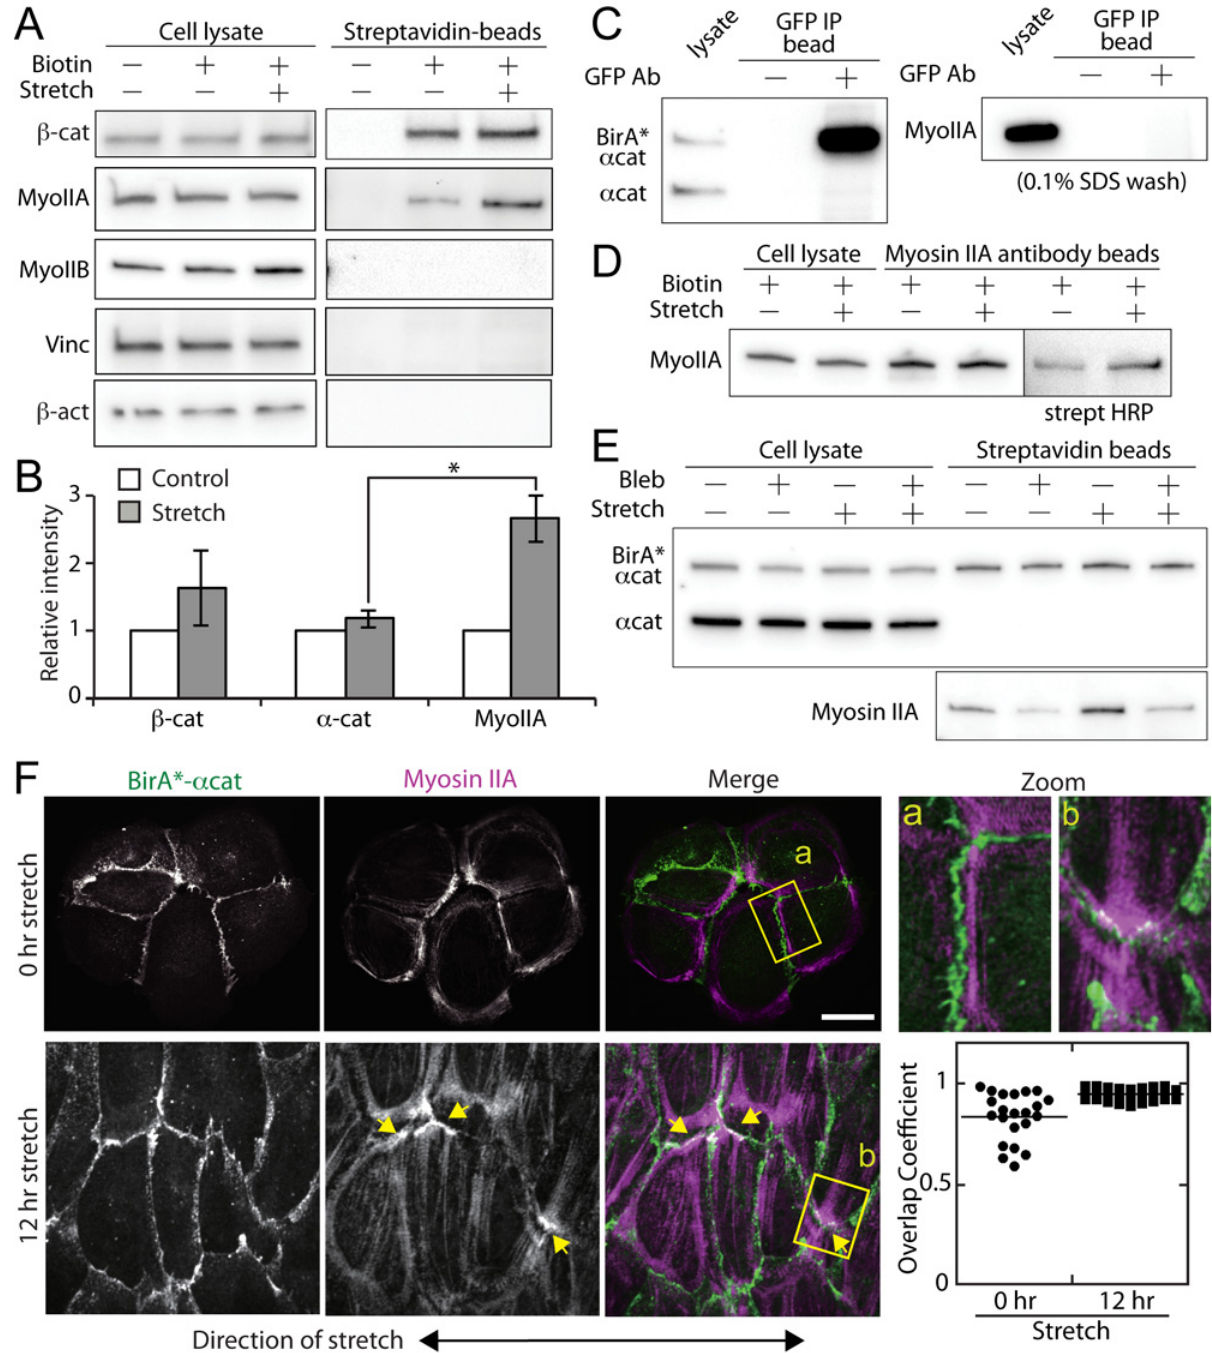
Fig 4. Increased biotinylation of myosin IIA in stretched cells. (A) Western blot analysis of cell lysates and purified streptavidin-conjugated beads from control and stretched cells. With 0.1% SDS wash solution, the purified proteins included β -catenin and myosin IIA. The biotinlyation of myosin IIA increased in mechanically stretched samples. Myosin IIB (MyoIIB), vinculin (Vinc) and β -actin ( β -act) were not purified with streptavidin-conjugated beads in unstretched or stretched samples. (B) Quantification of the relative band intensities of unstretched (control) and stretched (stretch) samples. β cat (n = 4), α cat (n = 4) and MyoIIA (n = 7). Results were analyzed using a one-way ANOVA; significance was determined using Dunnett ’ s post hoc test. Results were considered significant with P < 0.05. (C) Immuno-precipitation of GFP-tagged BirA * - α -catenin using a GFP antibody. The immuno-precipitated samples were analyzed with α -catenin and myosin IIA antibodies. The blot of α -catenin is reproduced from Fig 2B. (D) Immuno-precipitation of myosin IIA using a myosin IIA antibody. Immuno-precipitated samples were analyzed with a myosin IIA antibody and streptavidin. (E) Blebbistatin decreases biotinlyation of myosin IIA in both unstretched and stretched samples, suggesting that myosin IIA activity is required for the spatial proximity of α -catenin and myosin IIA. (F) Post-